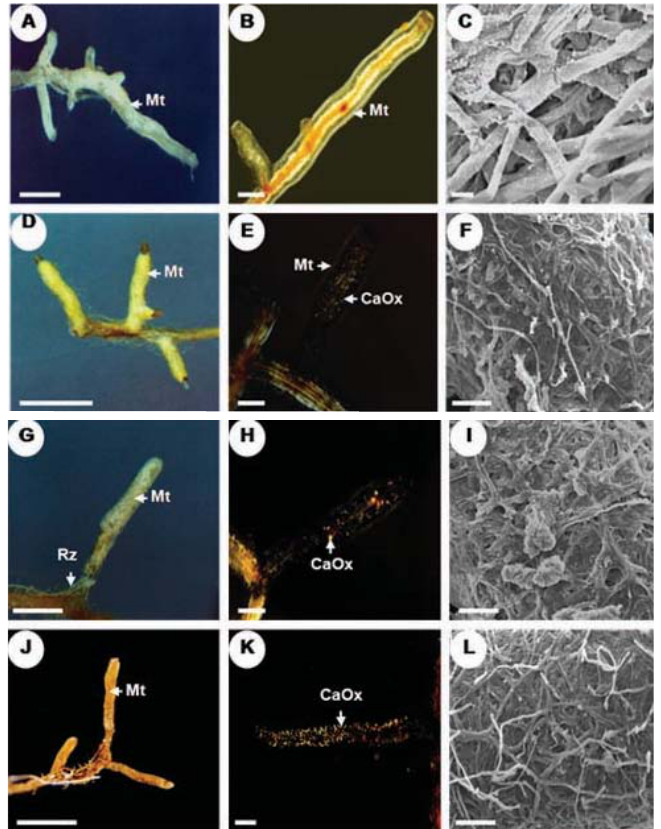
Figura 3. Morfologia de ectomicorrizas de híbrido de Eucalyptus grandis x Eucalyptus urophylla coletadas na encosta de área com topografia típica em meia laranja de vertente côncavo-convexa, observadas por microscopia óptica (A, D, G, J); por microscopia óptica de luz polarizada, para visualização de cristais de oxalato de cálcio (CaOx) (B, E, H, K); e por microscopia eletrônica de varredura (C, F, I, L). As três fotos horizontais correspondem a um morfotipo distinto. Os CaOx aparecem como pontos brilhantes nas estruturas diafanizadas. Barras: A, D, G e J = 1 mm; B, E, H e K = 200 μμμμμ m; C = 5 μμμμμ m; F = 15 μμμμμ m; I e L = 30 μμμμμ m.